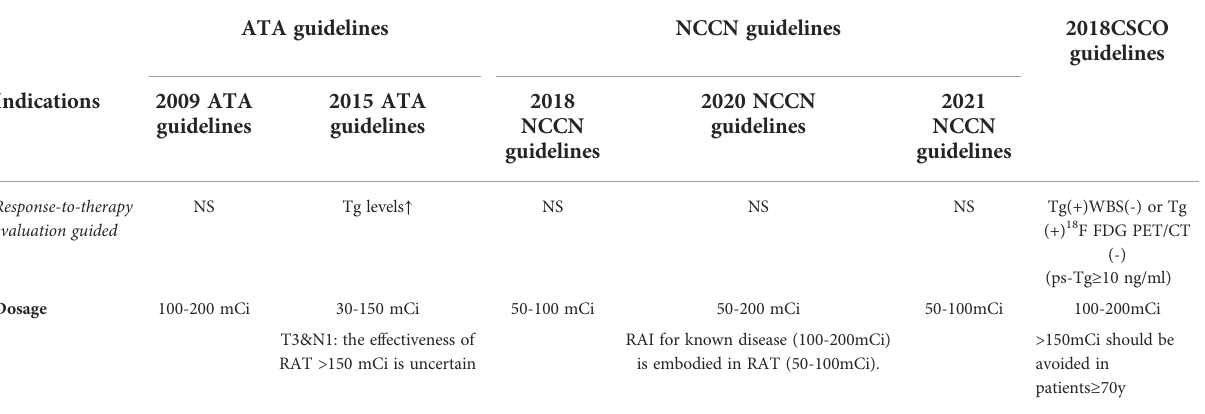
TABLE 6 Response to therapy evaluation guided RAT through guidelines.